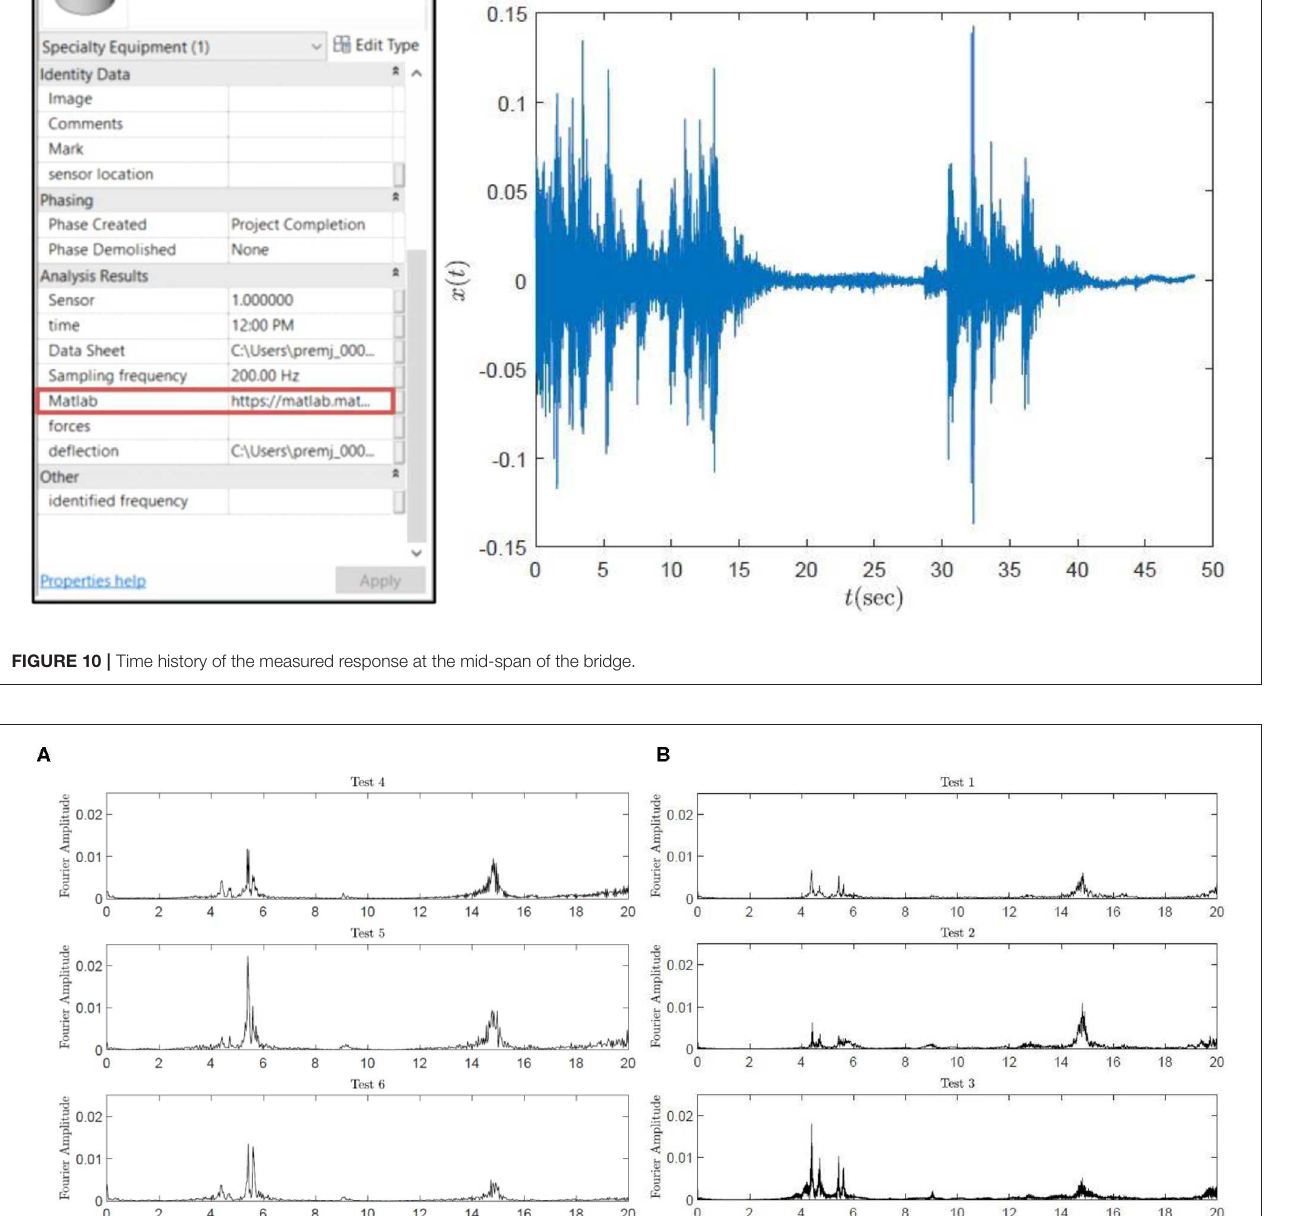
Figure 5A . The data collection was performed through the DAQ system by connecting it with sensors using BNC cables and a laptop using a USB cable shown in Figures 5B,C . Test details regarding the number and class of vehicles during each test run